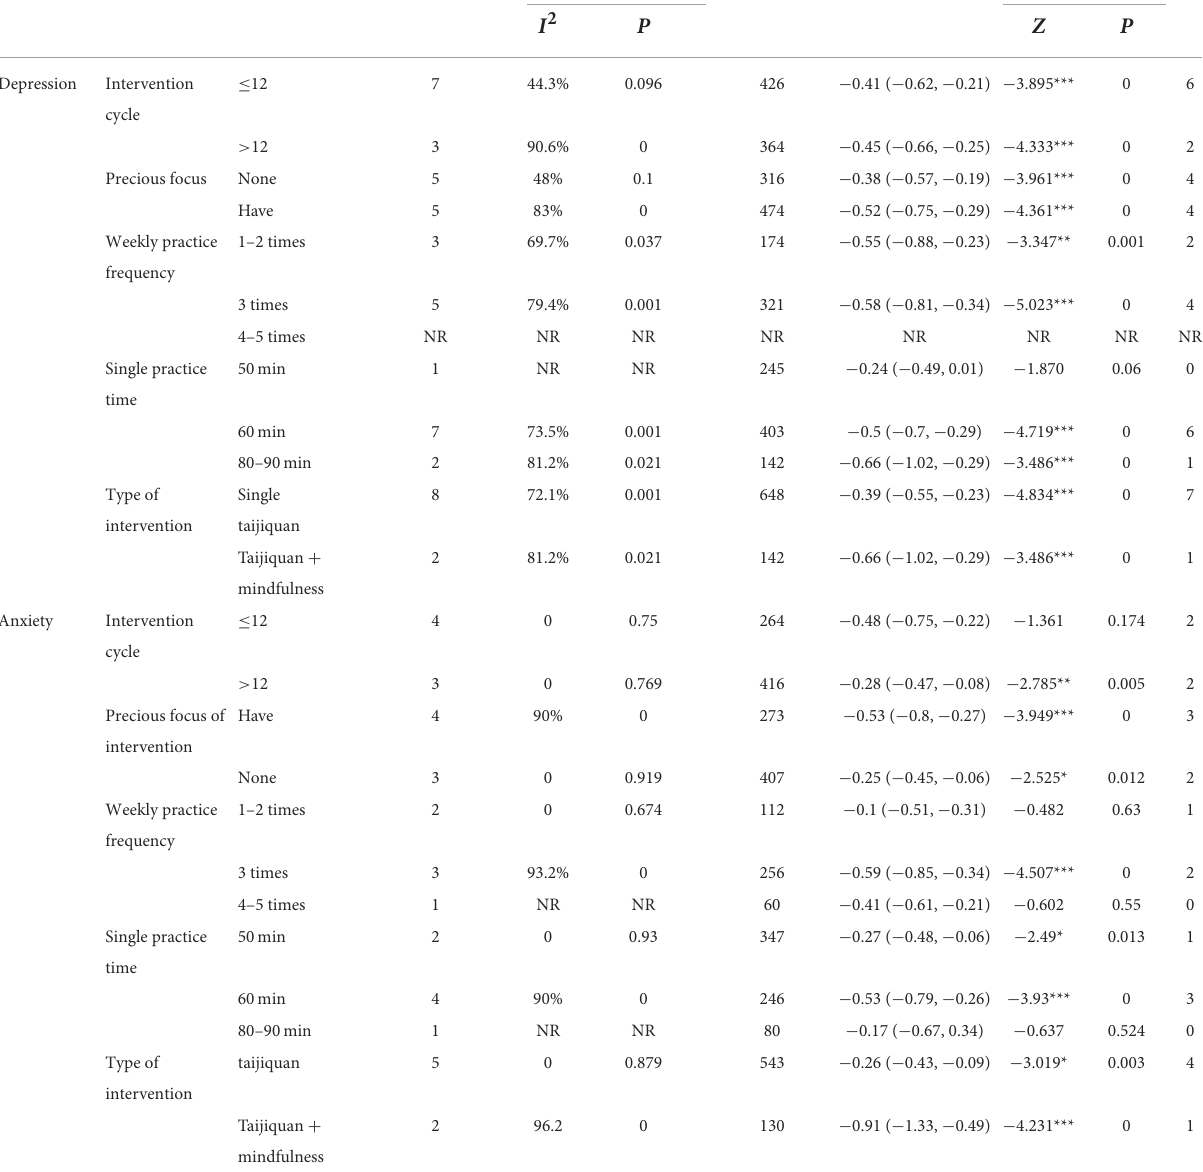
TABLE 4 Analysis of moderating